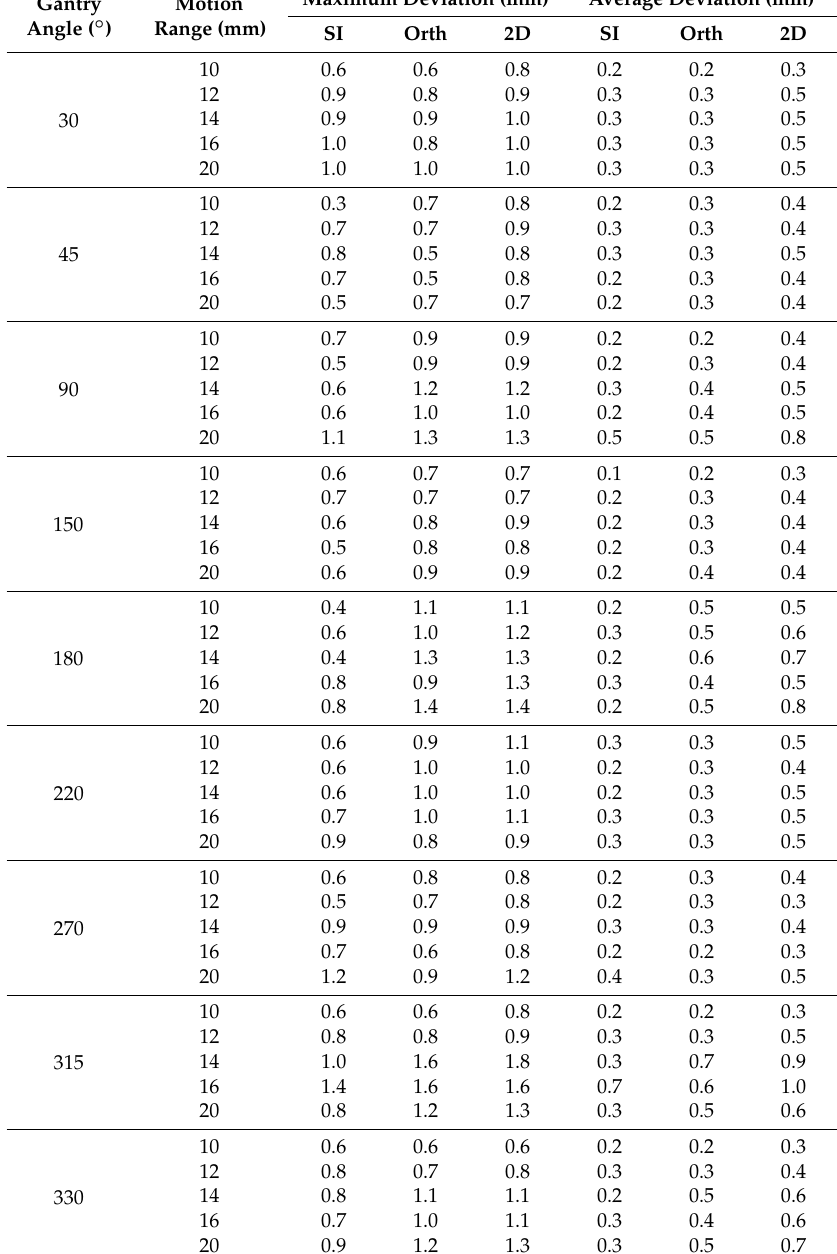
Table A2. Small tumor phantom tracking evaluation result summary. Superior–inferior (SI), orthogonal (Orth), and 2D deviation results are